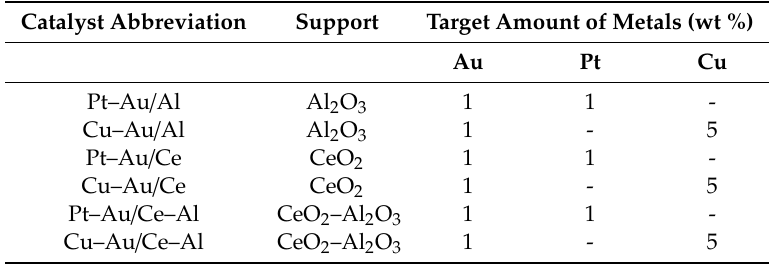
Table 6. Target compositions of the prepared bimetallic